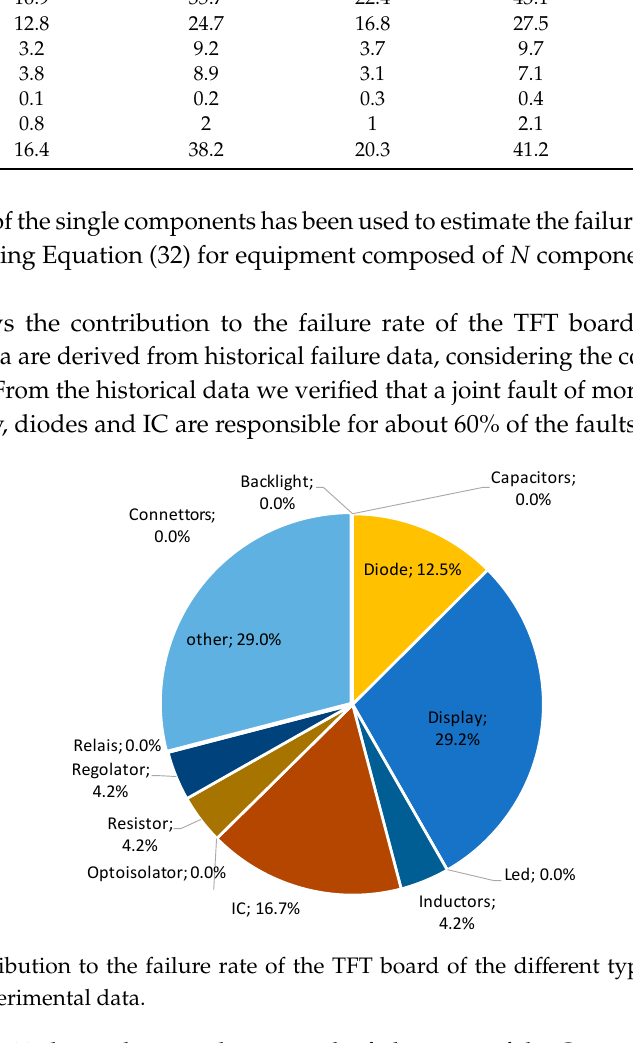
Figure 11. Contribution to the failure rate of the Control board of the different types of components, derived from experimental data. Figure 12. Contribution to the failure rate of the Control_new board of the different types of components, derived from model predictions.